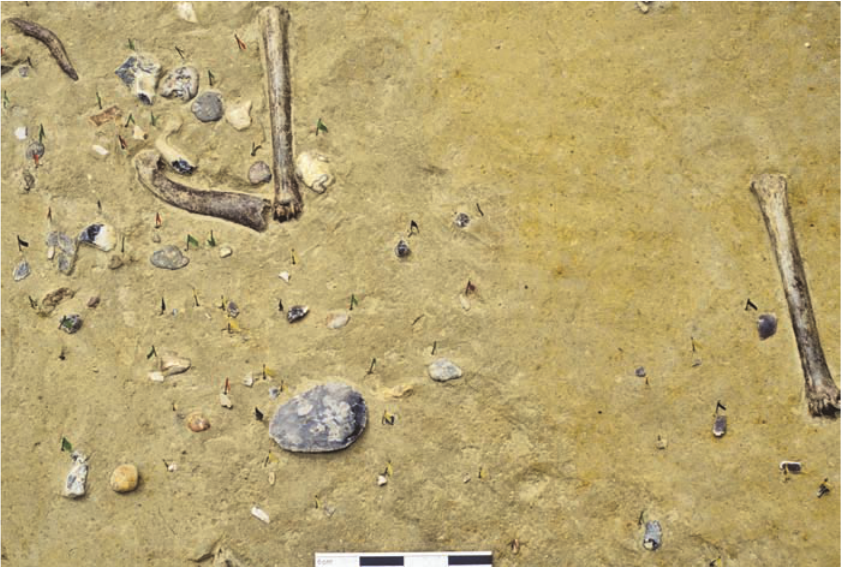
Figure 2 Lower limb bones of Cervus elaphus, a handaxe, flint flakes and beach pebbles, on the truncated surface of the marine sand at Boxgrove